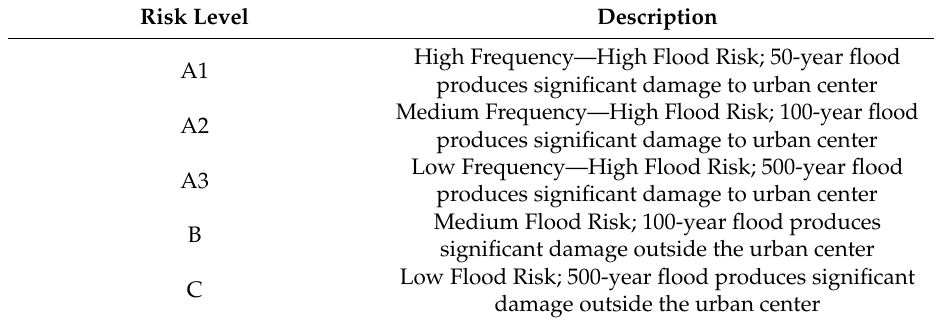
Table 2. Flood risk categories based on the Basic Directive for Civil Protection against Flood